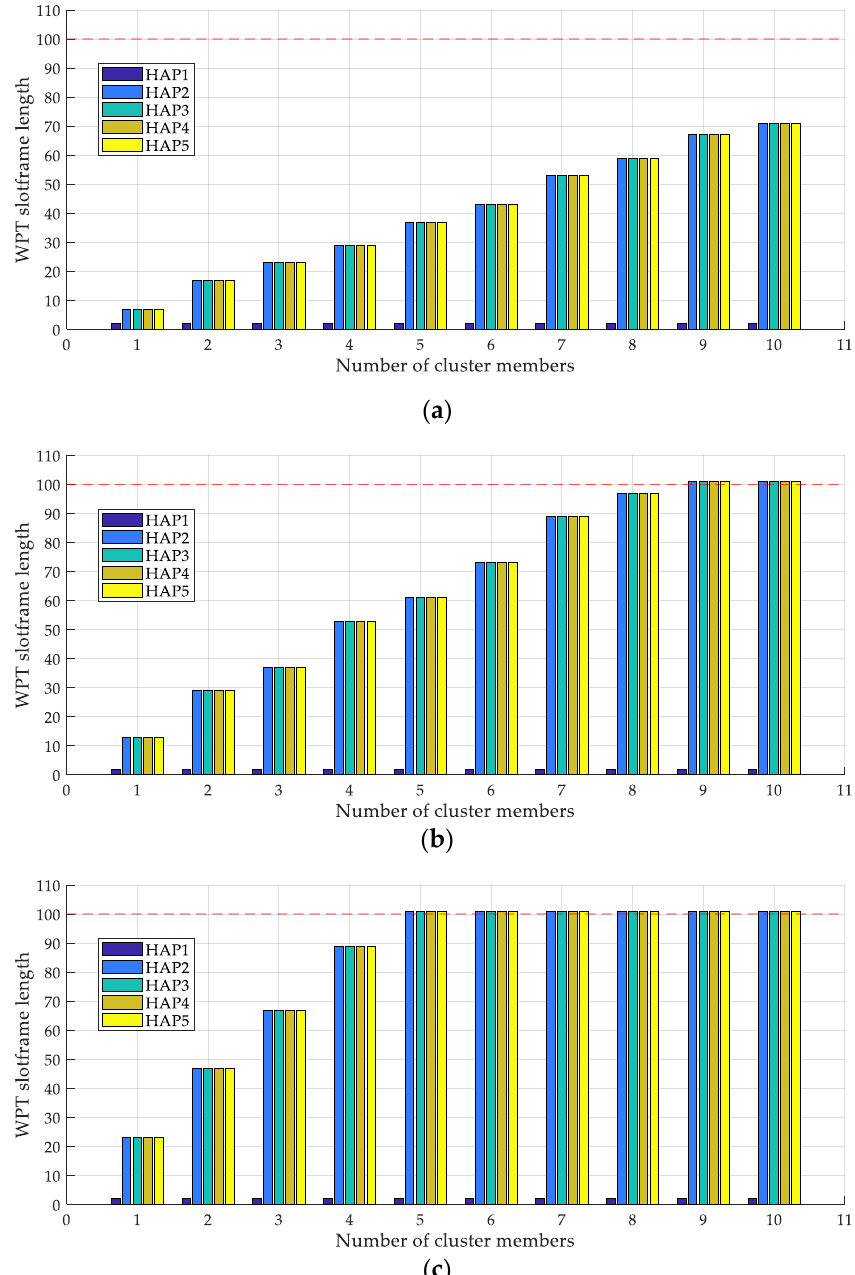
Figure 8. WPT slotframe lengths of HAPs: ( a ) one, ( b ) two, and ( c ) four packets/s.